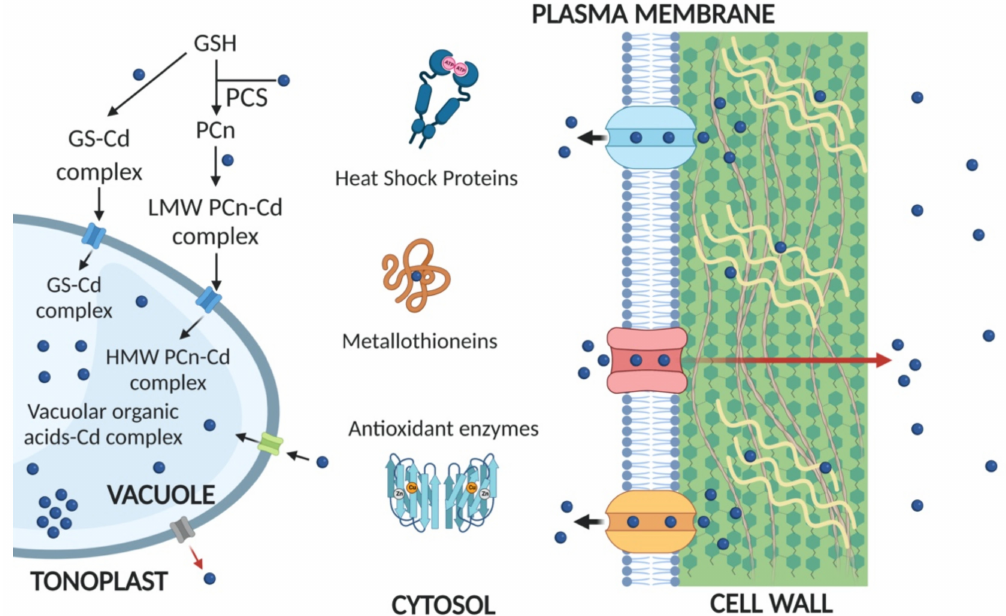
Figure 1. Cd transport and detoxification mechanisms in early-diverging streptophytes. Blue circles represent Cd. Red arrow shows a transporter-mediated Cd extrusion mechanism via transporters such as CDF (Cation Diffusion Facilitators) or PDR (ATP Binding Cassettes), whereas black arrows depict Cd internalization via different transporters such as NRAMP (Natural Resistance-Associated Macrophage Protein) or IRT (Iron-Regulated Transporter, ZIP family). Tonoplast transporters in blue represent systems responsible for Cd uptake into vacuole, such as HMA (Heavy Metal-Associated) or MRP (ATP Binding Cassettes). Tonoplast transporters in gray represent NRAMPs, which are responsible for Cd efflux out of the vacuole. GSH: reduced glutathione; GS-Cd: glutathione-bound Cd; PCn: phytochelatins; PCS: phytochelatin synthase; PCn-Cd: phytochelatin-bound Cd; Vacuolar organic acids-Cd complex: complex formed by Cd binding to Krebs acids and derivatives; LMW and HMW: Low and High Molecular Weight. Created with